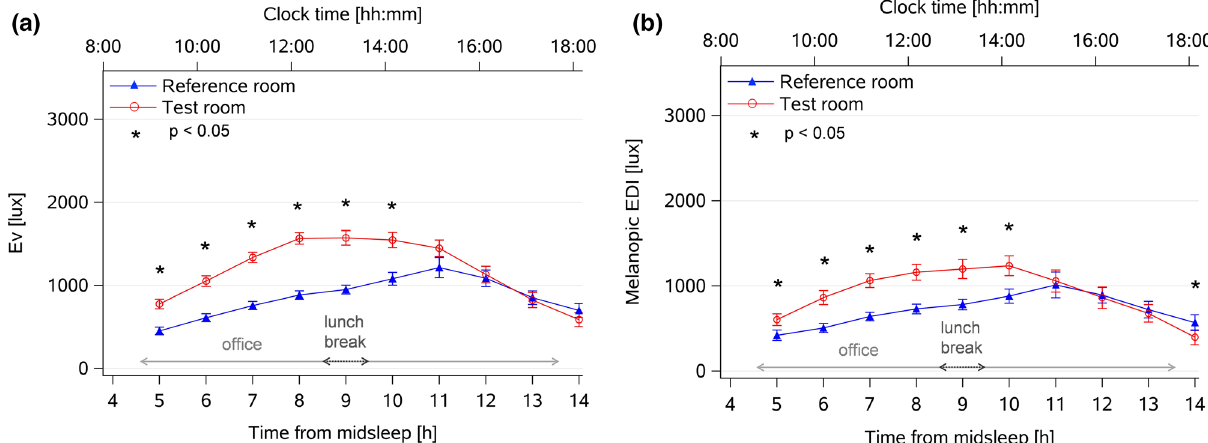
Figure 1. Time course of vertical illuminance (E v ) and melanopic EDI during office hours from stationary light sensors. ( a ) Time course of vertical illuminance (E v , lux) measured by stationary light sensors at the desk [at 1.2 m height from floor on a vertical plane at the approximate eye level of a sitting person (averaged across 5 days during office hours; n = 31 for the Reference and n = 34 for the Test room)]. ( b ) Averaged melanopic Equivalent Daylight (EDI) Illuminance (lux) at the desk (mean values ± SEM, n = 18; see text for more information). Symbols: Test room = red lines and circles; Reference room = blue lines and triangles (mean ± standard error; SEM)]; all values are aligned to elapsed time since habitual midsleep (lower x-axis). The upper x-axis also shows averaged clock times. The office sessions (indicated by the light grey vertical arrows) started approximately one hour after habitual waketime, and ended in the later afternoon. The dotted grey horizontal arrows indicate the lunch break (spent outside the office); * = significant differences between both conditions (with p values adjusted for multiple